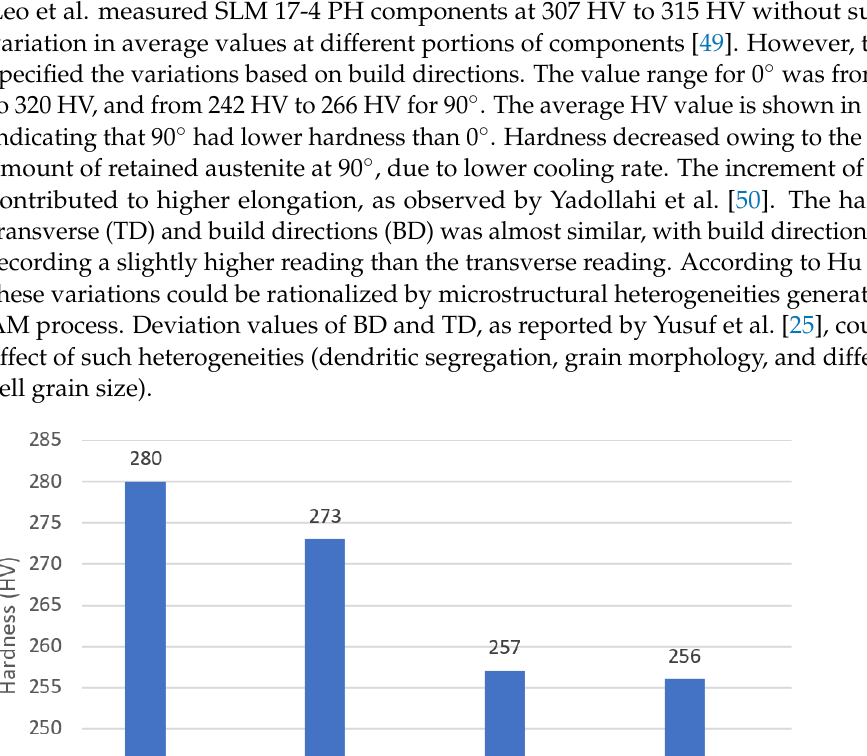
Figure 11. Identification of ( a , b ) austenite phase in build direction and transverse direction and ( c , d ) martensite phase in build and transverse direction.